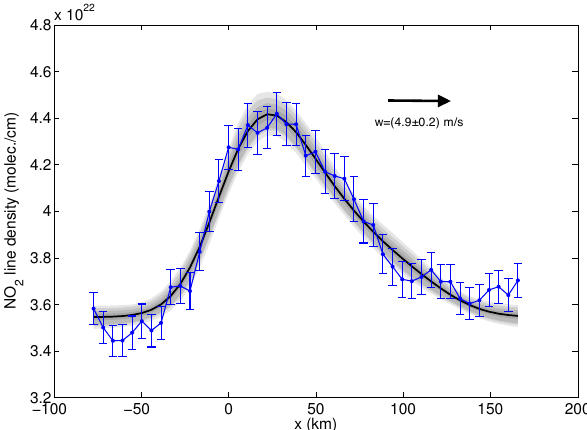
Figure 4. OMI NO 2 line density (blue color) for westerly wind con- ditions as a function of the distance ( x ) to/from Helsinki. Positive numbers in the x axis are eastward from the city center. The error bars were derived using the error propagation for the discrete in- tegral. The black line shows the MCMC fitted model and the grey areas correspond to the 50–99% probability uncertainty